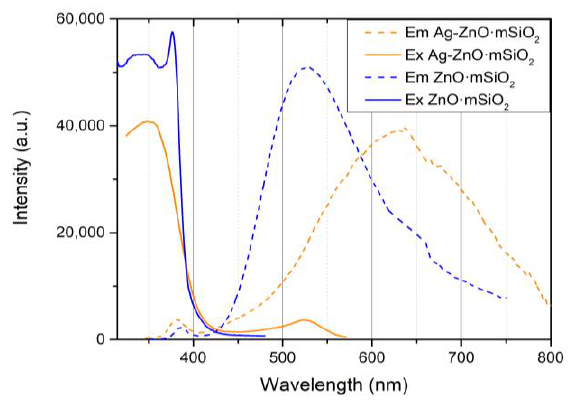
Figure 5. Photoluminescence spectroscopy of antimicrobial material Ag-ZnO· m SiO 2 and ZnO· m SiO 2 substrate. The solid lines are the excitation (Ex) spectra and dashed lines the emission (Em) spectra.